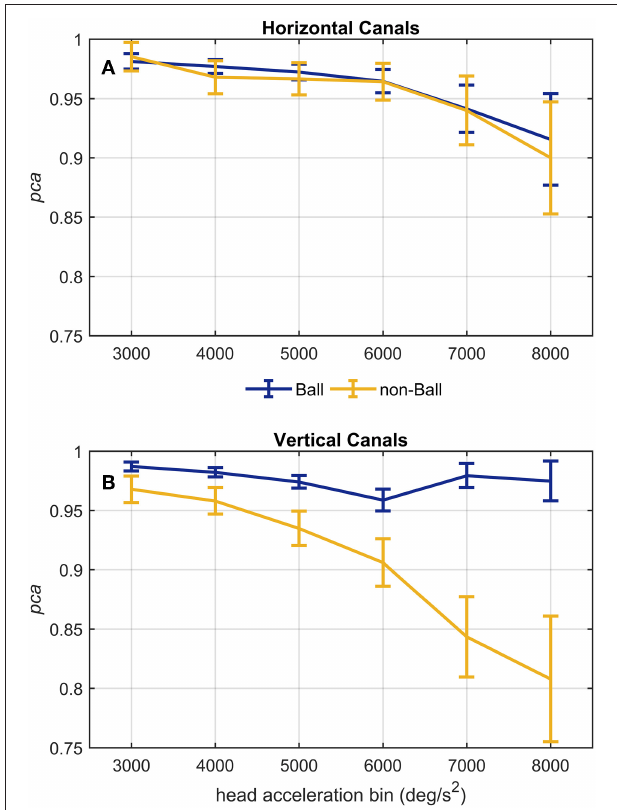
FIGURE 8 | Proportion of correct answers ( pca ) of ball and non-ball groups at different head acceleration bins. The error bars represent the pca and 95% confidence intervals estimated for bin of acceleration (3,000–8,000 deg/s 2 ) . Pca were computed using the single approach (Equation 1) for impulses performed in the plane ot the horizontal (A) and vertical (B) canals. Confidence intervals for pca were estimated as in Figure 3 . Dark blue and yellow lines represent the pca estimated for the ball and non-ball groups, respectively. (A) The relationship between head acceleration and test performance appeared comparable between the two subgroups of athletes (ball and non-balls) for the impulses collected in the plane of the horizontal canals. No significant difference was, indeed, found for every acceleration bin ( Table 4A ). (B) As visible, the two ball and non-ball subgroups showed two peculiar relationships of head acceleration and pca . The comparisons between the subgroups showed a significant higher pca of the ball group than the non-ball group, irrespective of head acceleration bins ( Table 4B